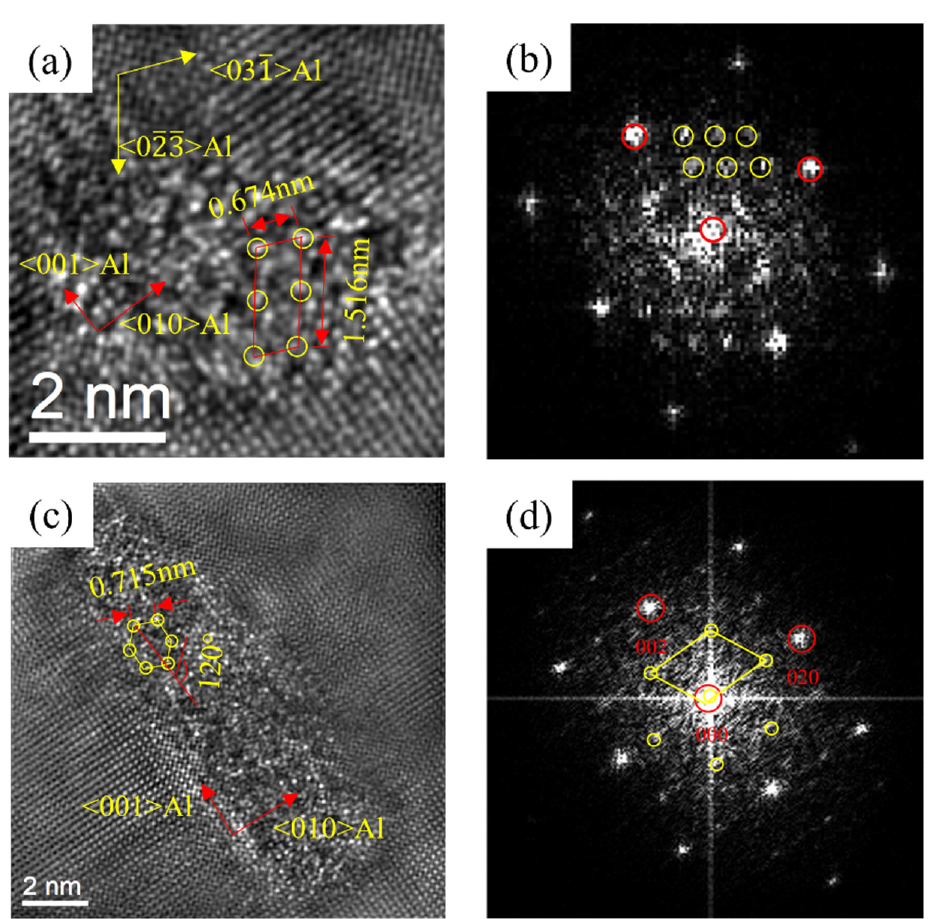
Figure 14. HRTEM and FFT patterns of 0.18Cu alloy after over-aging at 175 °C for 72 h. ( a , b ) β″ ; ( c , d ) β′ .